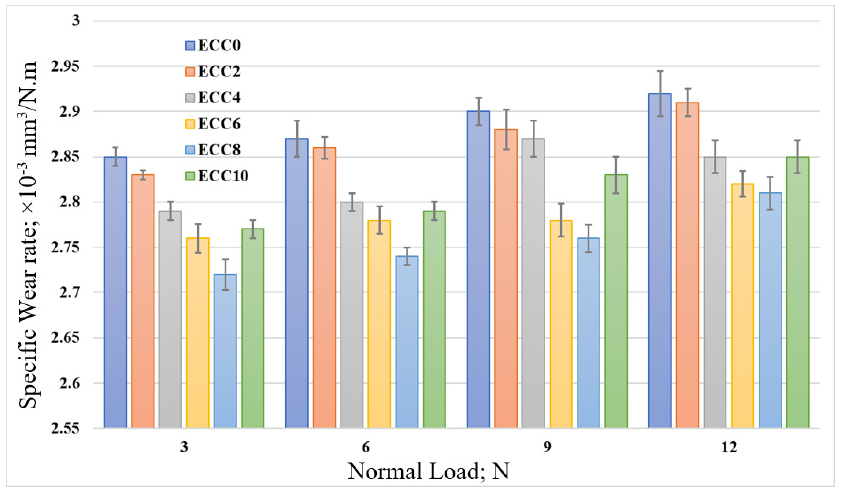
Figure 12. The specific wear rate of epoxy/corn cob composites under different normal loads.